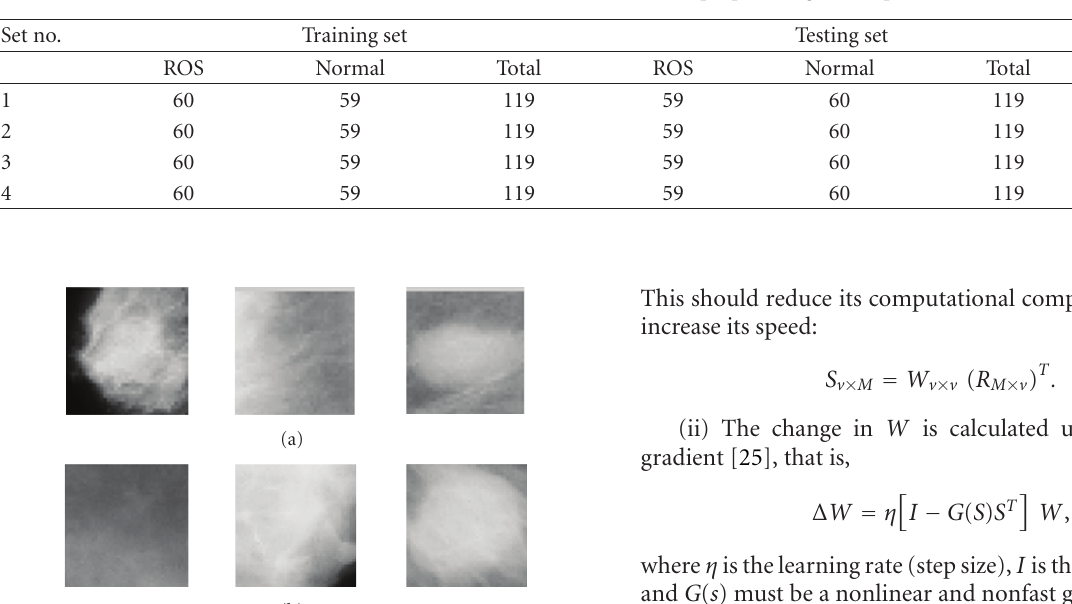
Table 2: Data sets that used in the evaluation of the proposed algorithm performance.